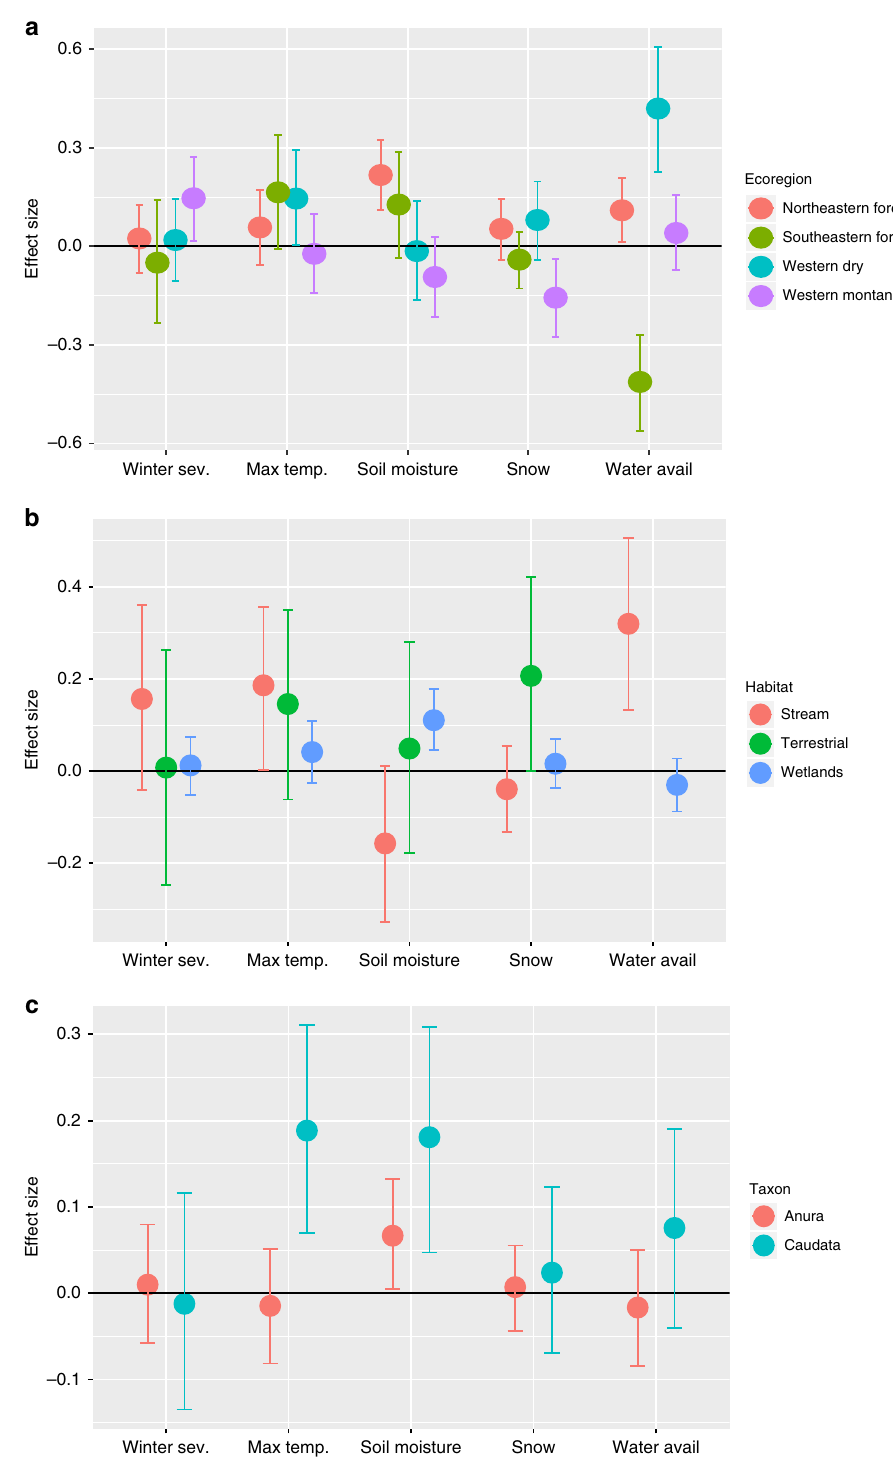
Fig. 3 Ecoregion, site, and taxonomic differences in the relationships of climate variability to colonization and persistence probability. We estimated the relationship between annual conditions for fi ve climatic drivers and species turnover and how it varies among ecoregions ( a ), site type ( b ), and taxonomic grouping ( c ). Effect size is on a logistic scale and represents the effect of a 1-SD change in the climate covariate on colonization and persistence. Error bars are the 95% credible interval for the estimate. Positive values indicate a location is more likely to be occupied in years after an increase in the climate covariate (higher colonization and persistence probability), whereas negative values are associated with declines in years with higher values. Plotted effect sizes for categorical variables are the group mean effects. For example, greater winter severity, as measured by higher values of the air-freezing index, was associated with increased colonization and persistence for species in the Western Montane region. Estimates and SE for effect sizes can be found in Table